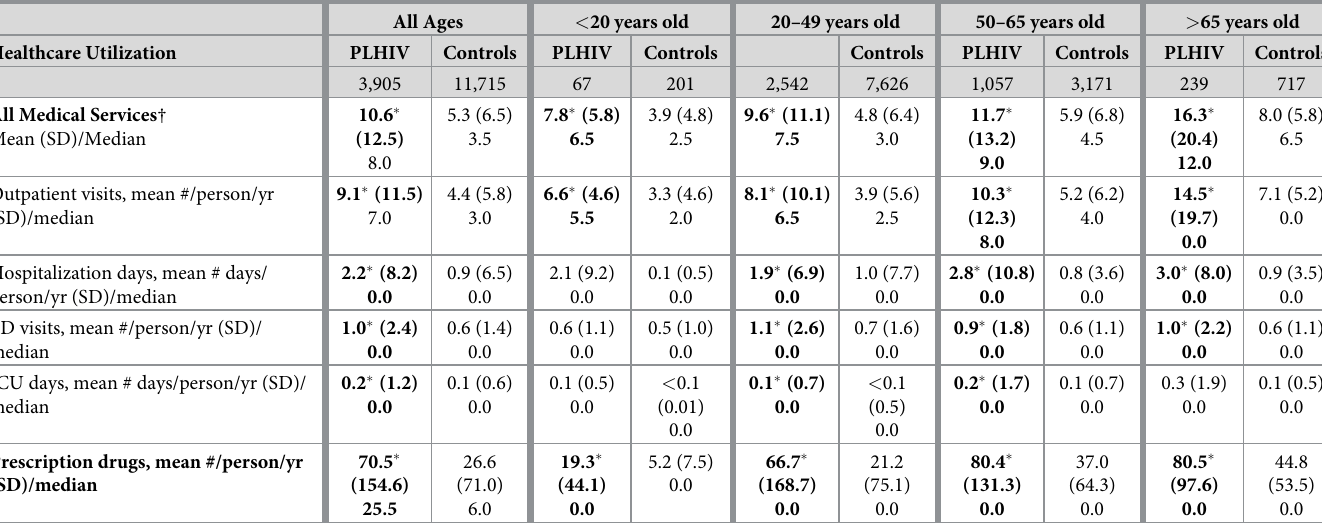
Table 2. Healthcare utilization in the 2 years following cohort entry for PLHIV in different age groups compared to controls. All Ages < 20 years